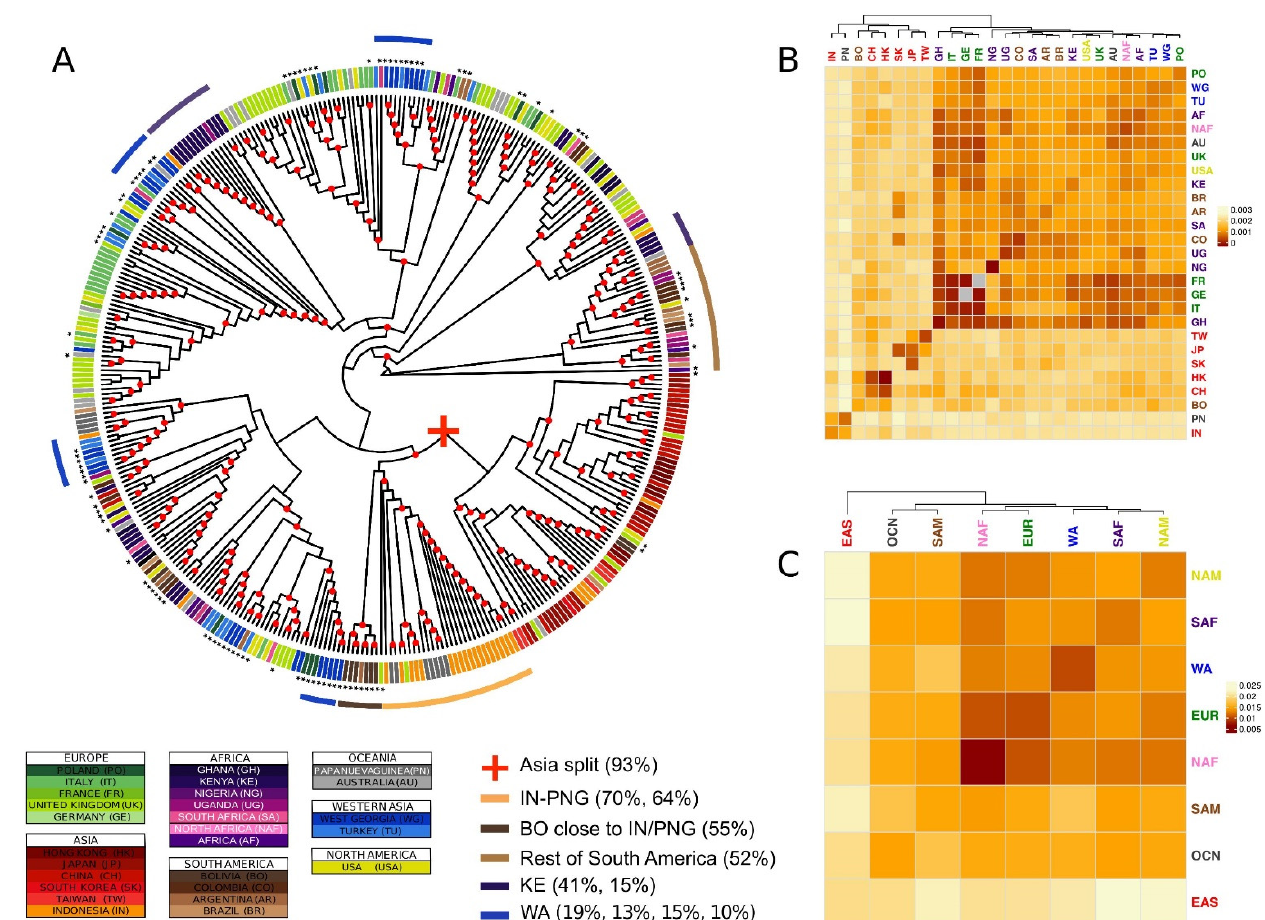
Figure 1. Major phylogenetic relationships. ( A ) Supertree generated by combining the phylogenies of all genes. The strain labels are coloured by country of origin. The countries of the same continent are coloured by different shades of the same colour. The new sequences produced in this study are identified by black asterisks. Nodes with bootstraps values higher than 0.5 are indicated with a red circle. ( B , C ) Heatmap representing the bootstrapped pairwise genetic distances between EBV populations weighted per all genes in the data set. Populations IDs correspond to the country of origin ( B ), or the continent of origin ( C ), and are coloured by continent. The colour of the heatmap cells is proportional to the genetic distance value (the closer the populations, the darker red the cell colour). Groups of isolates mentioned in the text are reported together with the proportion of the total number of isolates of the geographical origin.